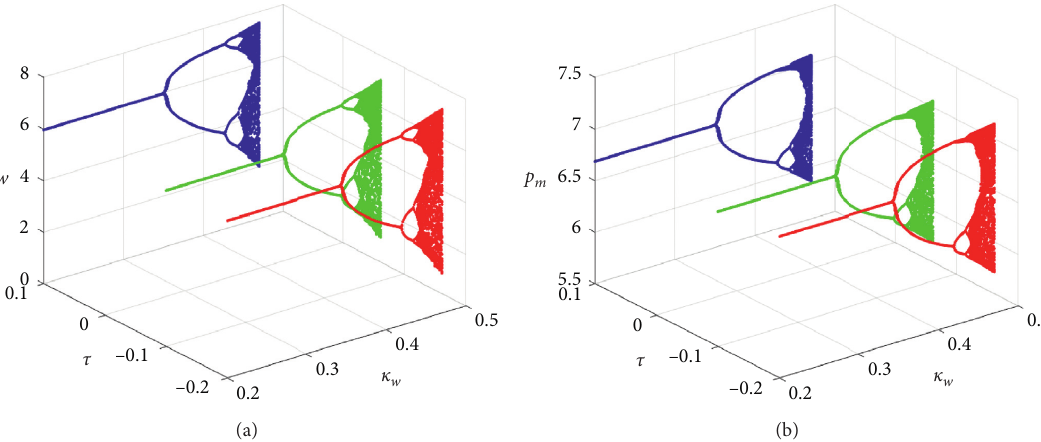
Figure 3: 3D bifurcation diagrams of w in (a) and p